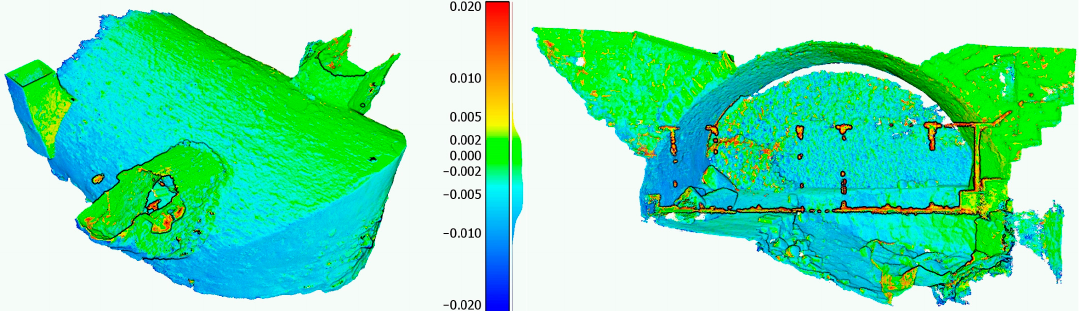
Figure 18. Deviations in the comparison of photogrammetry with all images active and the variant without connection through opening 2 (A vs. D) in the ossuary (external view on the left , cross-section on the right ).